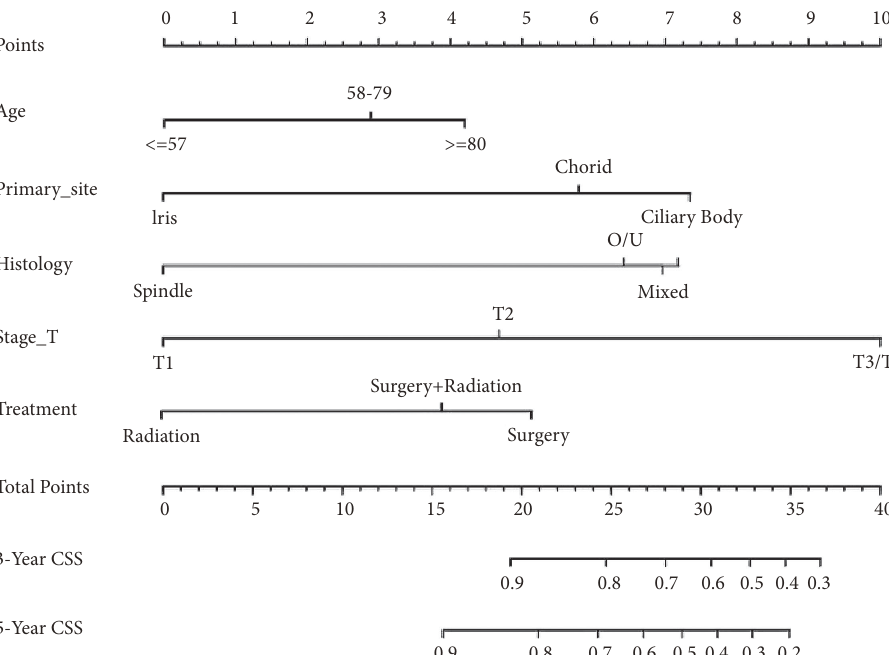
Figure 3: Nomograms for the prediction of the 3- and 5-year CSS values for patients with UM without metastases. CSS: cancer-specific